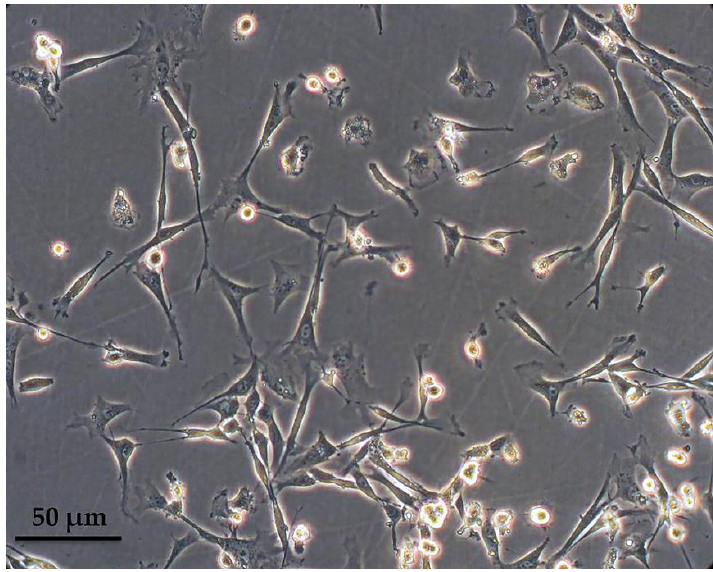
Figure 1. Ovine macrophages, after three weeks in culture. Cells were derived from the peripheral blood mononuclear fraction after ficoll separation and were left to mature in macrophage-specialized media supplemented with fetal bovine serum.